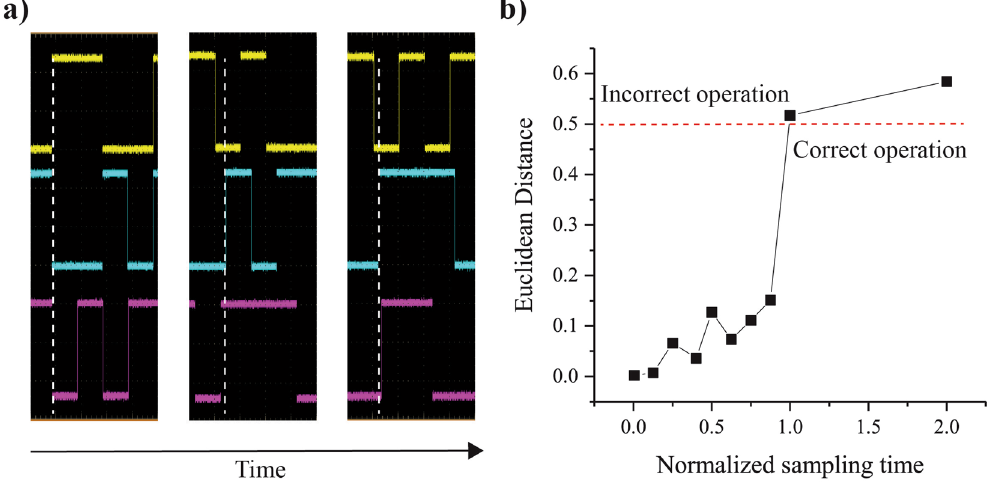
τ Figure 5. Normalized sampling time ( ) sampling . ( a ) An oscilloscope snapshot of the 3 p-bits is shown above as it τ N changes as a function of time. Initially all 3 p-bits are almost perfectly aligned with extremely small phase differences between them. As time goes on this alignment is broken allowing each p-bit to update separately which leads to the system naturally having serial updates. ( b ) The euclidean distance between the steady state distribution of implemented hardware (as a function of sampling time τ sampling ) and the Boltzmann law is plotted as a function of normalized sampling time. The sampling time τ sampling of the AND gate is varied from 1 ms to 400 ms, while the retention time of all p-bits is 200 ms. For proper operation there is a hard threshold for the sampling time τ sampling which is close to the retention time τ N for a system with all p-bits having the same retention time. This condition reduces the probability of more then one p-bits getting updated